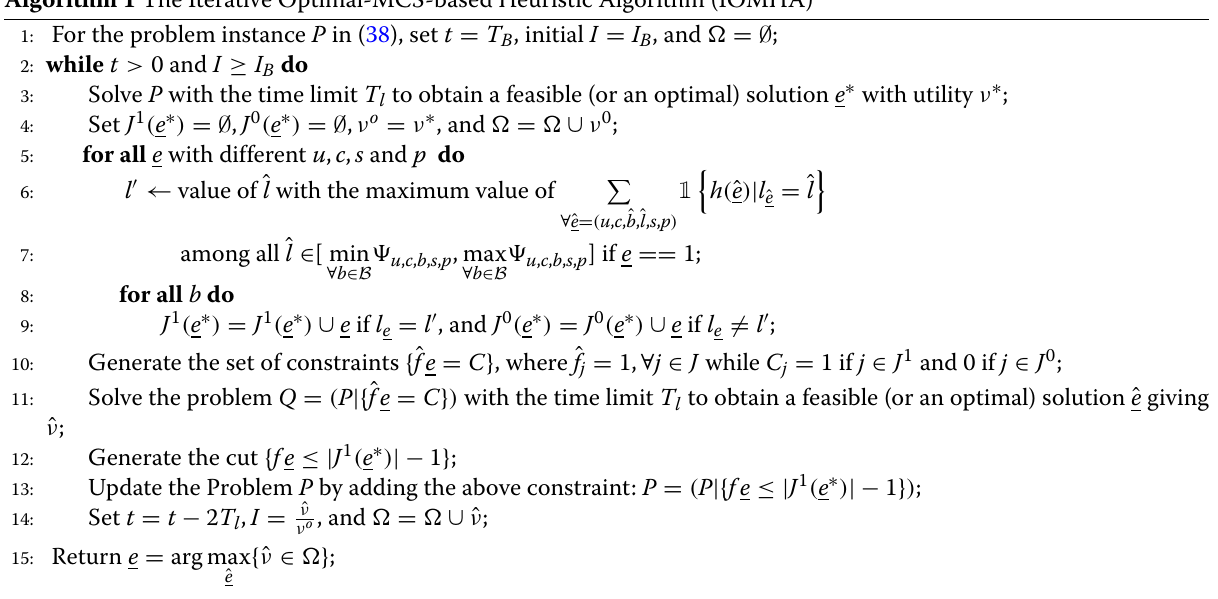
Algorithm 1 The Iterative Optimal-MCS-based Heuristic Algorithm